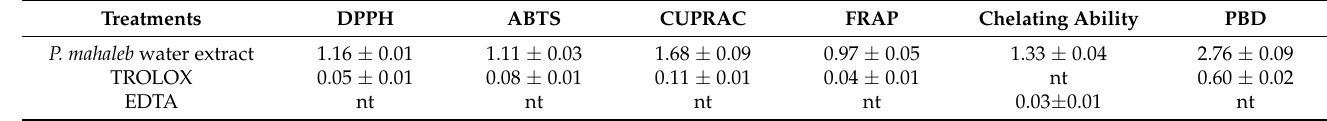
Table 1. Scavenging/reducing properties.